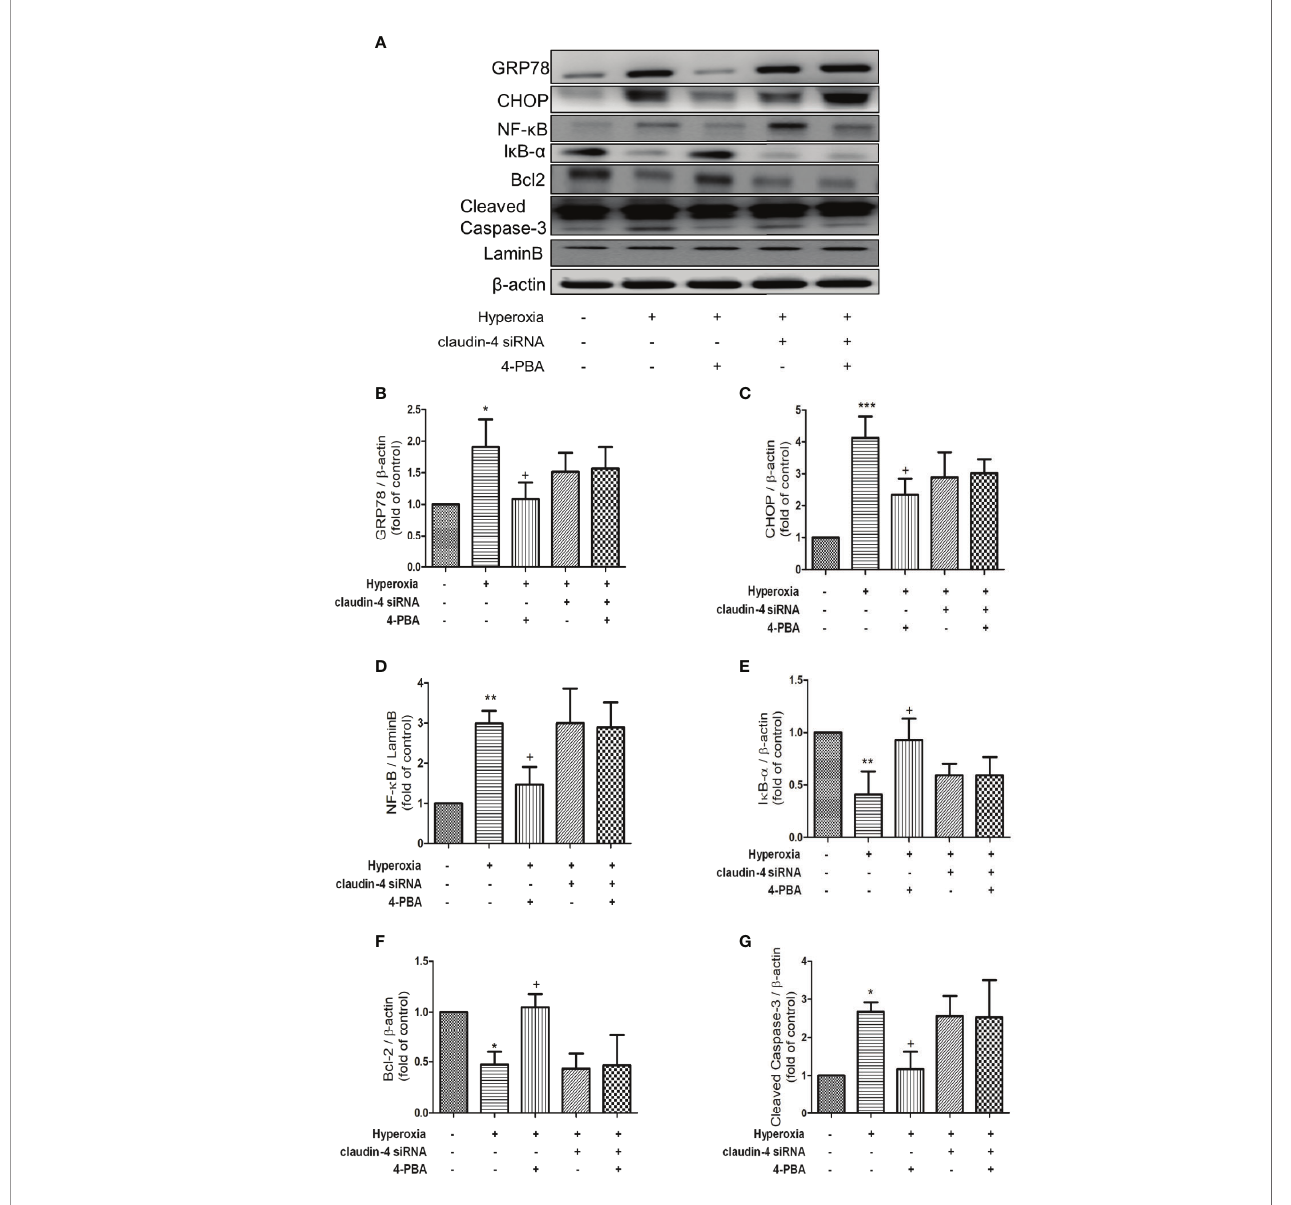
FIGURE 10 | Claudin-4 knockdown attenuates the effect of 4-PBA in GRP78 and CHOP protein expression, NF- k B signaling pathway, and apoptosis in mice with hyperoxia-induced lung injury. (A) Western blot analysis of GRP78, CHOP, NF- k B, I k B- a , Bcl-2, and cleaved caspase-3 expression in lung tissues. Relative expressions of GRP78 (B) , CHOP (C) , NF- k B (D) , I k B- a (E) , Bcl-2 (F), and cleaved caspase-3 (G) in lung tissues were shown. The results are expressed as the mean ± SD; n=3. *p < 0.05, **p < 0.01, ***p < 0.001, compared with the control group; + p < 0.05, compared with the hyperoxia